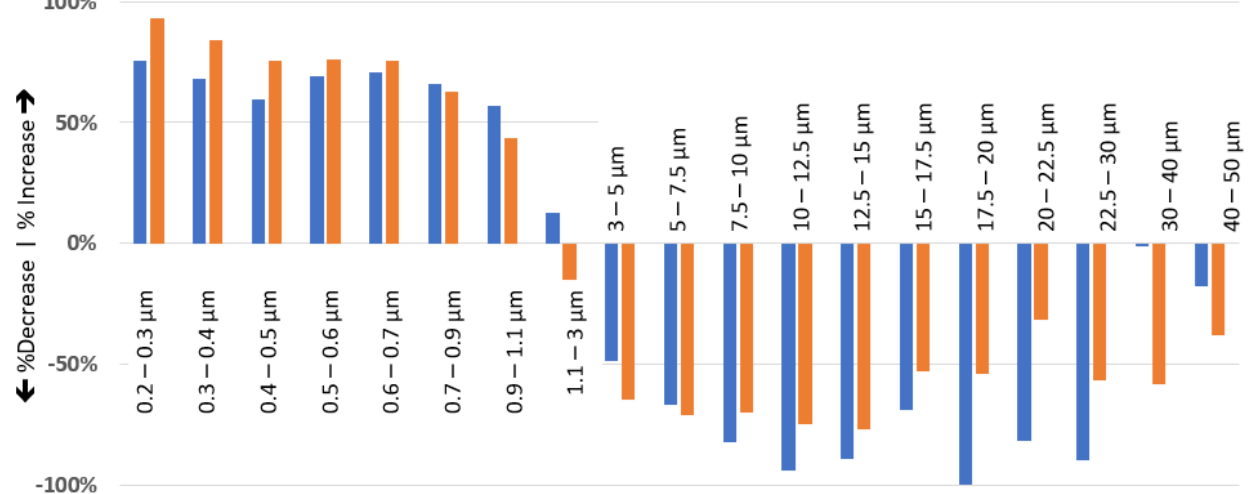
Figure 6. Percent change in PM concentrations by particle size range.